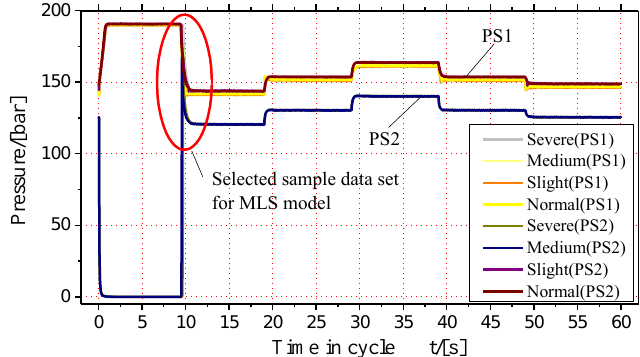
Figure 2. Fixed working cycle (measured by partial PS1 and PS2) with a pre-defined load.